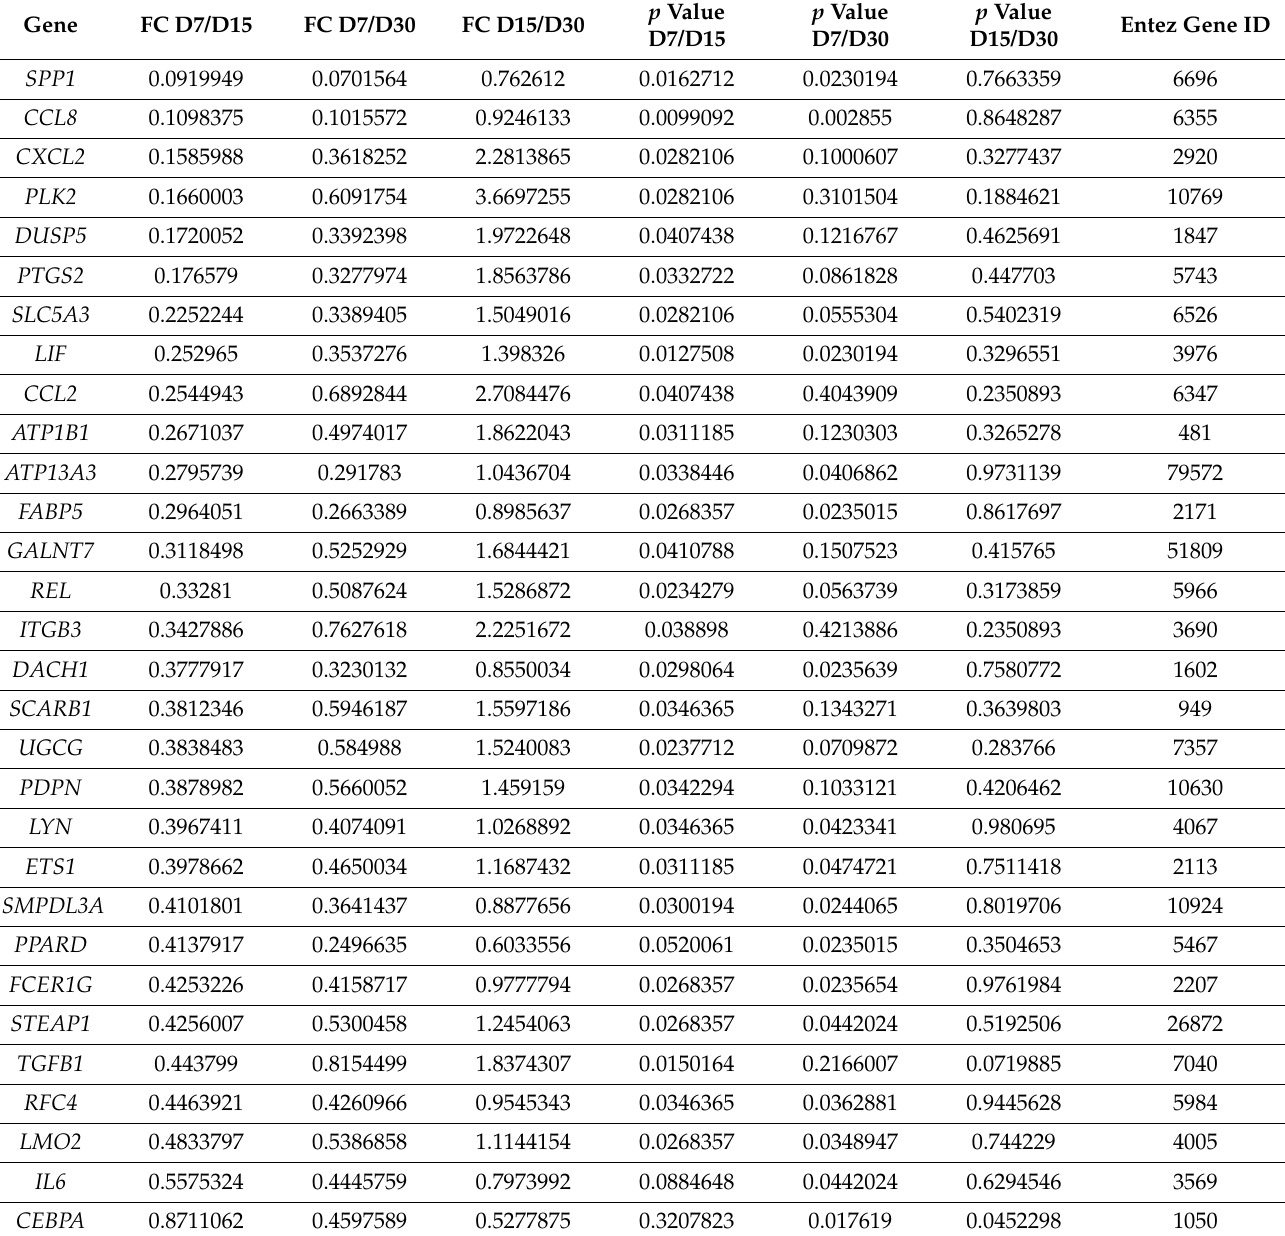
Table 2. Gene symbols, fold change in expression ratio, Entrez gene IDs, corrected p values, and mean value of fold change ratio of studied